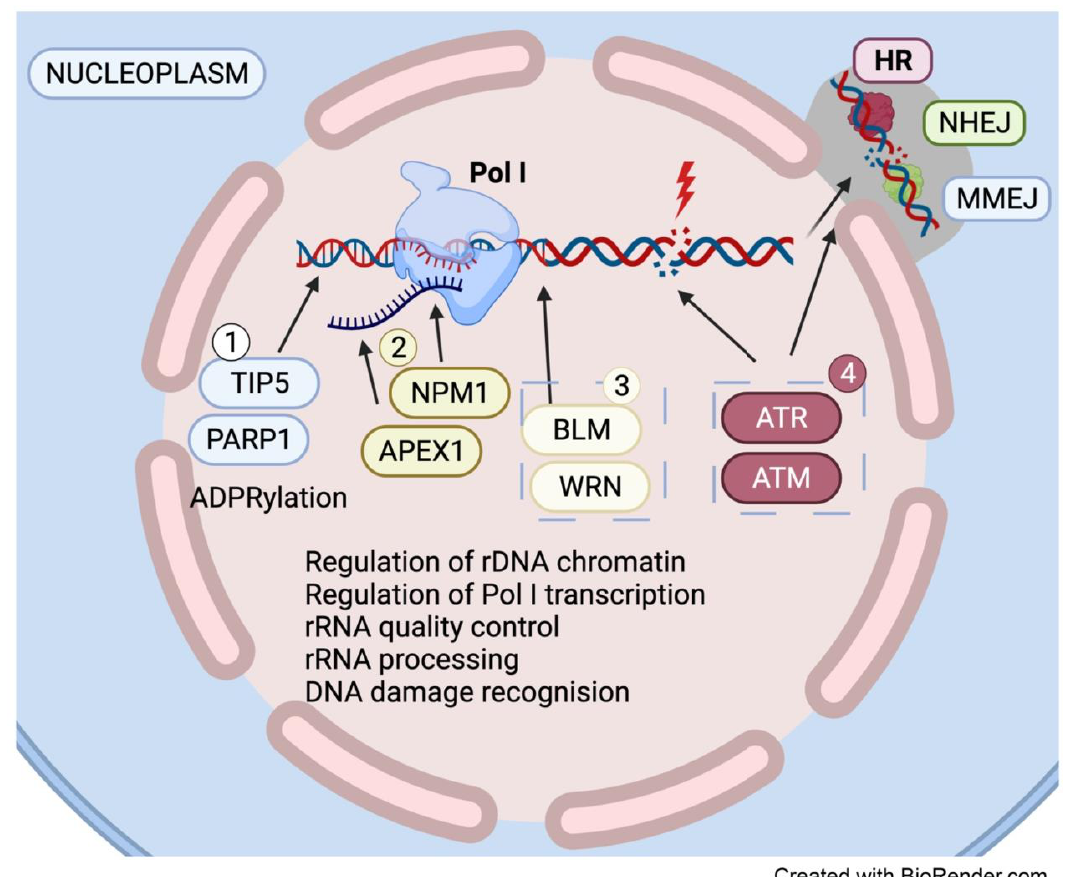
Figure 4. The Nucleolus is a hub for DDR factors. Several DDR factors reside in the nucleolus and may play a dual role in ribosome biogenesis and rDNA repair. (1) PARP1 mediates the PARylation of TIP5 which leads to rDNA silencing and Pol I transcription control. (2) APEX1 interacts with the multi-functional nucleolar protein NPM1 and mediates rDNA repair and rRNA quality control. (3) RecQ-like helicases WRN and BLM reside in the nucleolus and interact with Pol I to facilitate Pol I transcription. (4) Classic DDR factors ATM and ATR are also found in the nucleolus and are involved in an extensive network of factors involved in RNA trafficking, processing, and transcription apart from their role in repairing damaged rDNA.